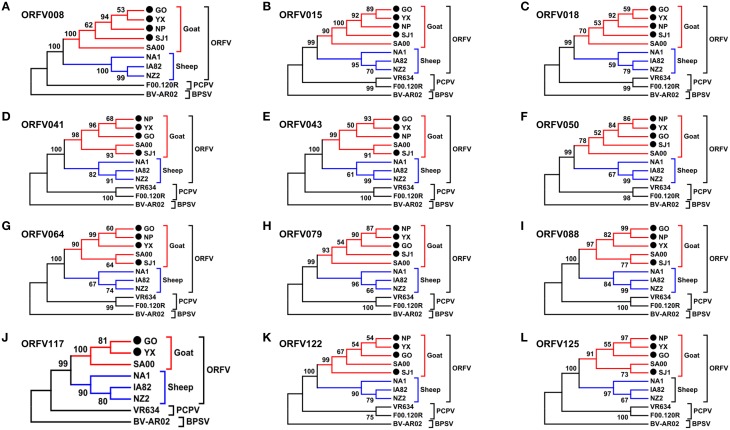
Phylogenetic analysis based on nucleotide sequence of ORFV single gene distinguishing goat and sheep origination. The phylogenetic relationship was constructed by the maximum-likelihood method using MEGA 5.0 software. Numbers at the branching points indicate the bootstrap support calculated for 1000 replicates. (A) ORFV008. (B) ORFV015. (C) ORFV018. (D) ORFV041. (E) ORFV043. (F) ORFV050. (G) ORFV064. (H) ORFV079. (I) ORFV088. (J) ORFV117. (K) ORFV122. (L) ORFV125.